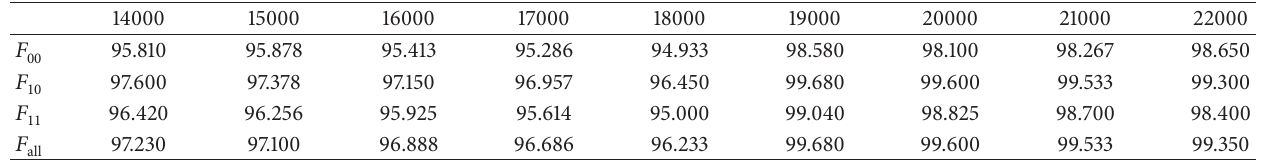
Table 2: Classification accuracy rates (%) (24000 samples).